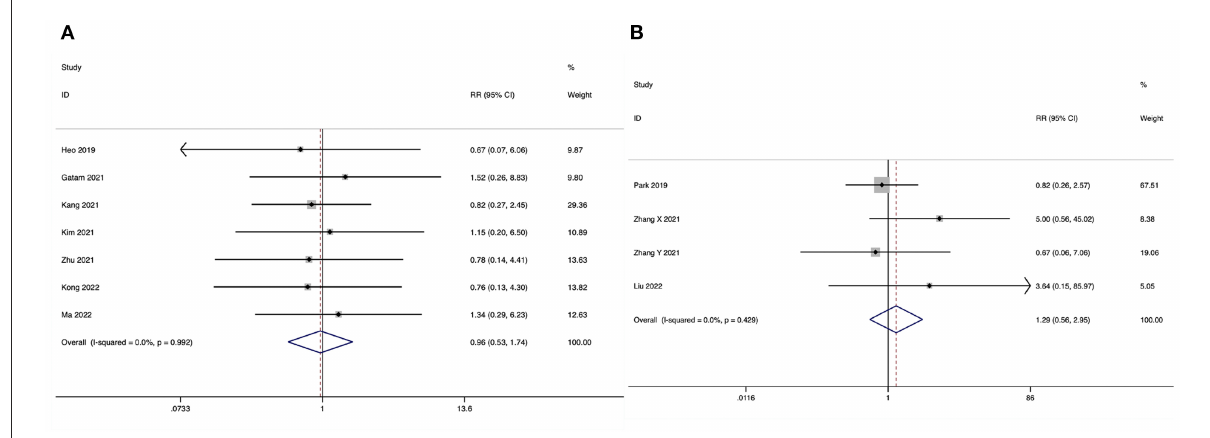
FIGURE10 Forest plot of the overall surgical complication rate. (A) ULIF vs. MI-TLIF; (B) ULIF vs. PLIF.